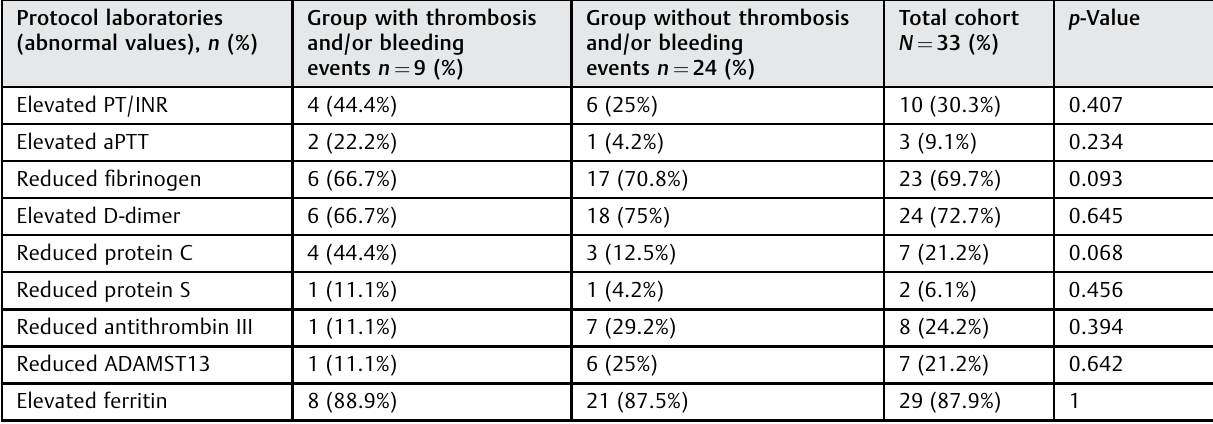
Table 3 Abnormal protocol laboratories between the groups with and without thrombosis and/or bleeding events Protocol laboratories Group with thrombosis (abnormal values), n (%) and/or bleeding